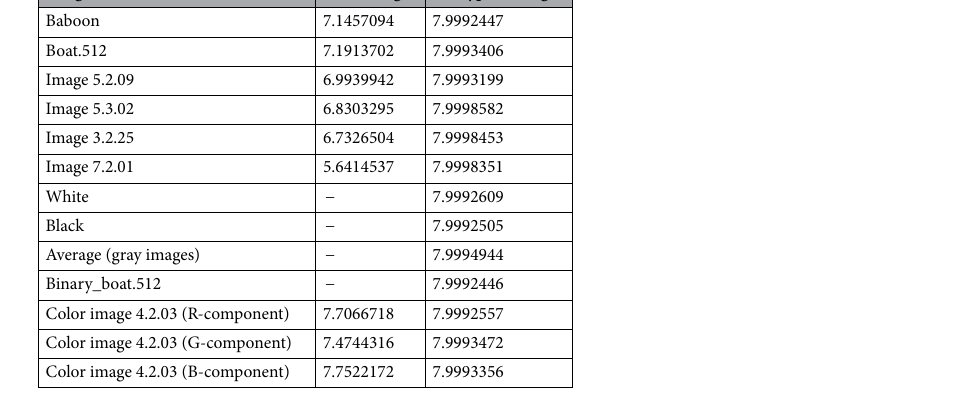
Table 4. Information entropy of images.